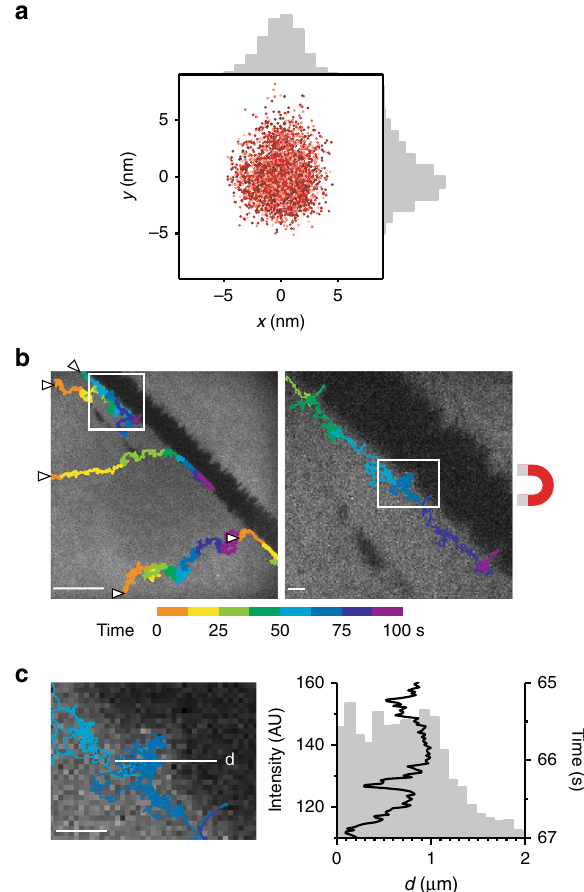
Fig. 2 Accuracy of FMNP localization and tracking. a Plot of subsequent 2D localizations of a single immobile FMNP on a SLB by sub-pixel fi tting in each frame (total 3000 localizations, imaged at 50 Hz), colored by time (light to dark red). b Trajectories of SLB-bound FMNPs under magnetic pull (beginning marked with arrowheads) overlaid onto the fl uorescence image of the SLB (gray) with defects (black areas). Scale bars are 10 μ m and 1 µ m. c Fluorescence micrograph of inset in b and plot of FMNP localization in direction of the white line (d) over time above plot of SLB fl uorescence intensity along (d). Scale bar is 1 μ m. Source data are provided as a Source Data fi